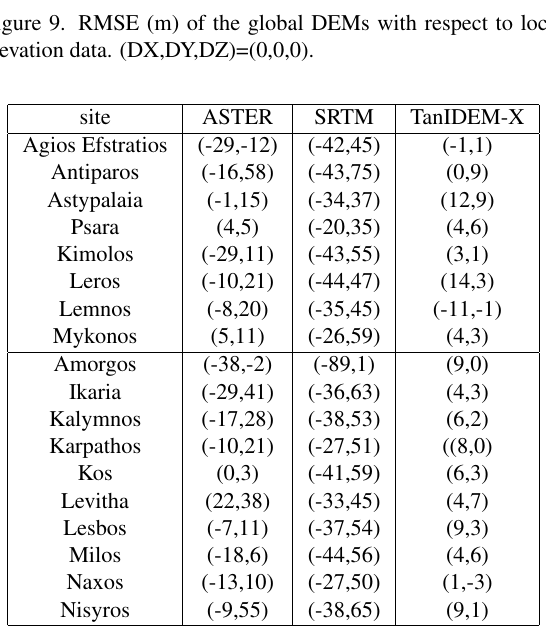
Figure 10. 3D translation distance D of the global DEMs with respect to the local elevation data.